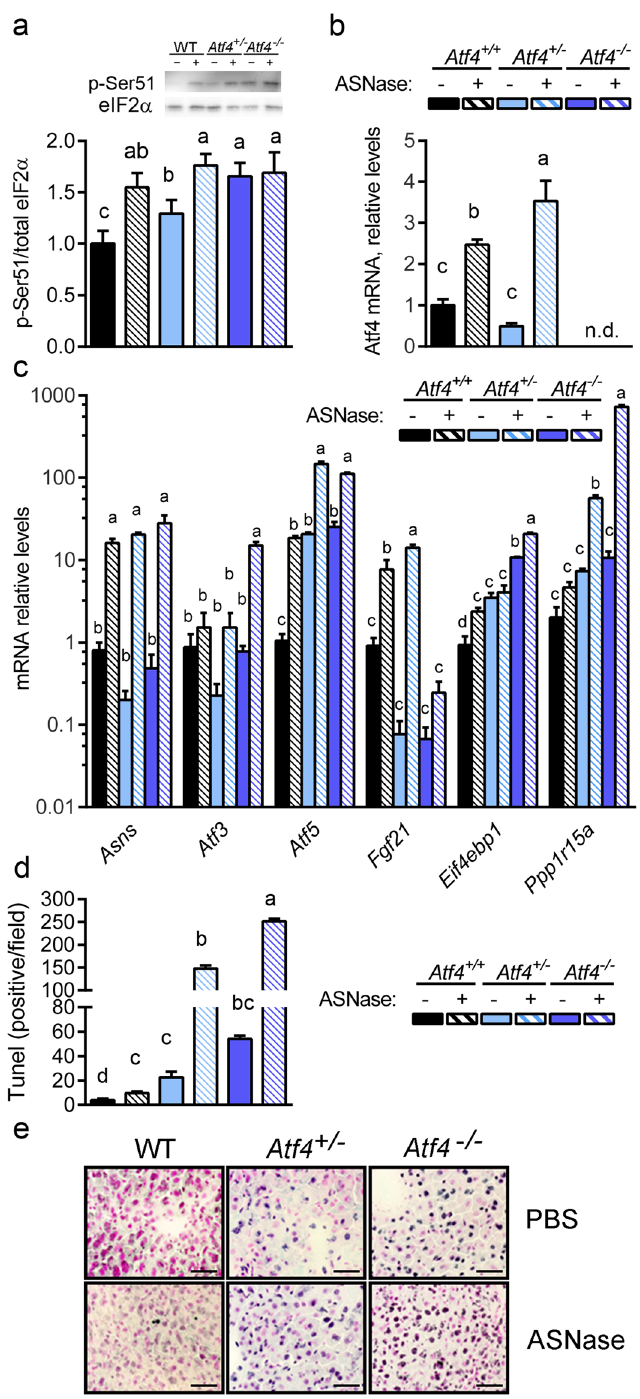
Figure 6. Atf4 haploinsufficiency amplifies the hepatic AAR and liver damage in response to 8 daily injections of asparaginase (3 IU per gram body weight, ASNase). ( a ) Phospho-eIF2 alpha was measure by immunoblot analysis and quantified relative to total eIF2 alpha. ( b ) Gene expression of Atf4 in liver as measured by RT- qPCR. n.d. = not detectible. ( c ) Hepatic expression of ISR genes Asns , Atf3 , Atf5 , Fgf21 , Eif4ebp1 , and Ppp1r15a in WT, Atf4 + / − and Atf4 − / − mice. ( d ) Apoptosis was ascertained in de-identified histological sections by manual counting of TUNEL-positive nuclei using Image J software. ( e ) Fragmented DNA visualization by TUNEL method in representative frozen liver sections (10 μ m thick). Images taken at 40X magnification show visual features determined in WT, Atf4 + / − and Atf4 − / − mice. Scale bar represents 50 μ m. Data are represented as the average value ± standard error of the mean, n = 3–6 per group. Means without a common letter are different according to Tukey post hoc analysis following ANOVA, P < 0.05. Full immunoblots are presented in Supplementary Fig.